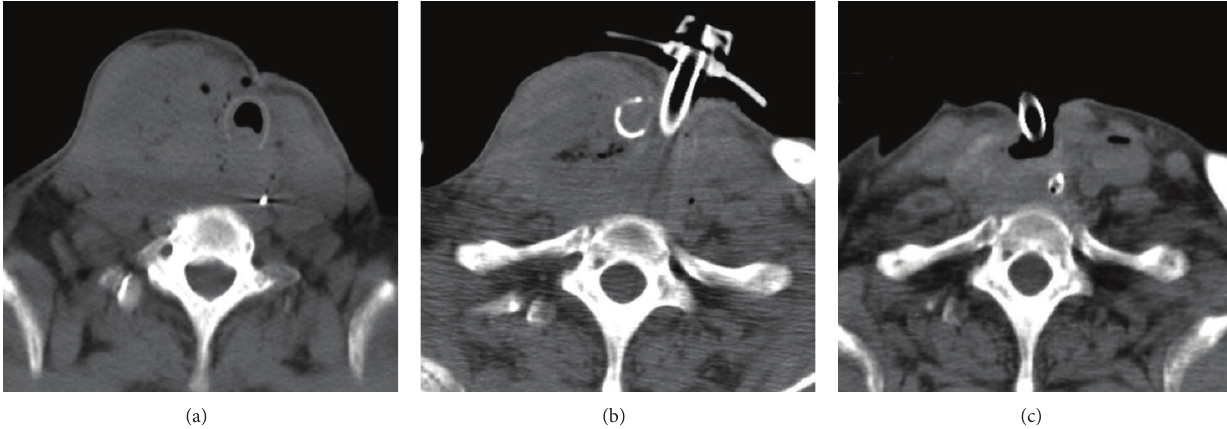
Figure 1: ATC in a 75-year-old woman. The cervical mass was inseparable from the strap muscles, tracheal wall, and carotid sheath. (a) Computed tomography scan showing a huge mass in the right thyroid robe on admission, (b) after surgical resection of a part of tumor and tracheotomy, and (c) after radiotherapy and seven cycles of